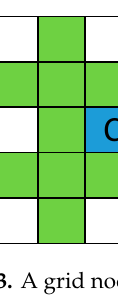
Figure 3. A grid node with neighbors.